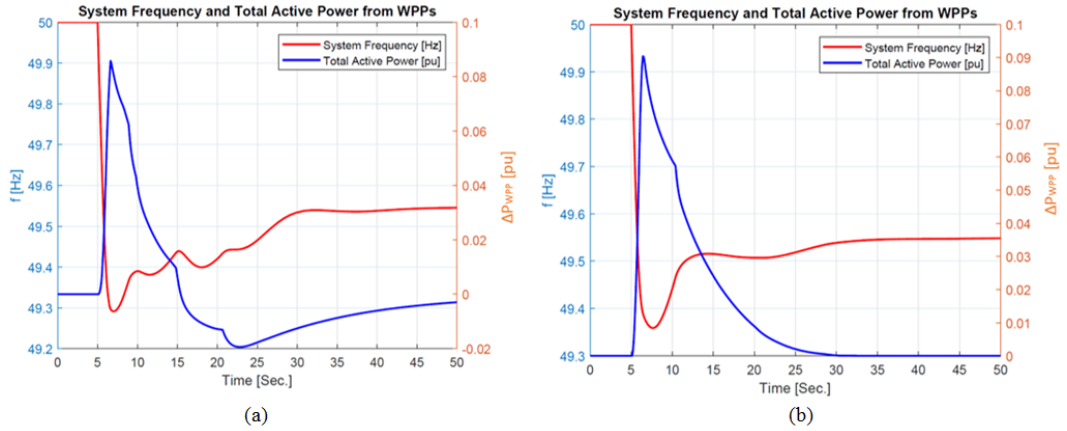
Figure 9. Reference System Frequency and Total Active Power from WPPs for ( a ) Partial Load (i.e., 7 m/s average wind speed) and ( b ) Full Load (i.e., 14 m/s average wind